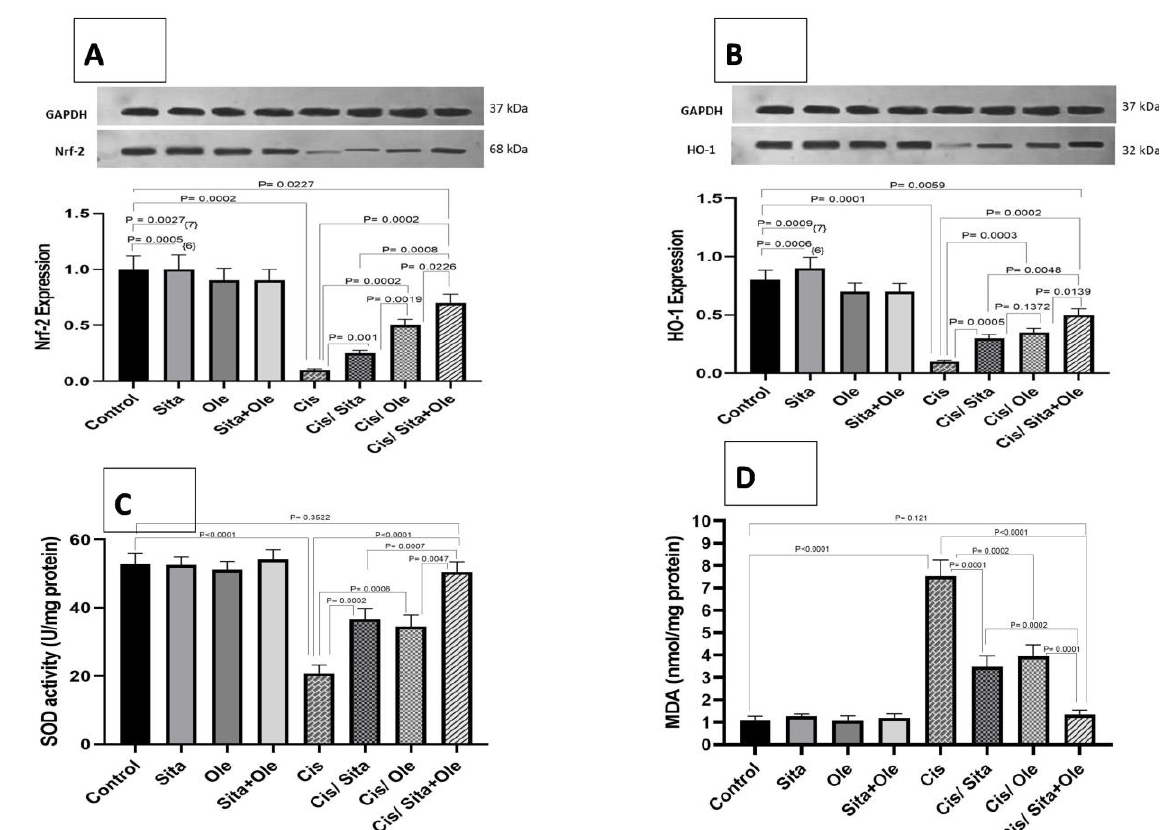
Fig. 8. Effect of sitagliptin and oleuropein on cisplatin-induced oxidative stress; A: protein expression of Nrf-2; B: protein expression of HO-1 as shown by Western blot analysis in renal tissue, bars represent corresponding protein expression levels relative to GAPDH; C: SOD (unit/mg of tissues); D: MDA (nmoles per mg tissue). Data are presented as means ± SD. P < 0.05 is considered statistically significant; one-way ANOVA followed by Bonferroni-corrected post hoc tests were